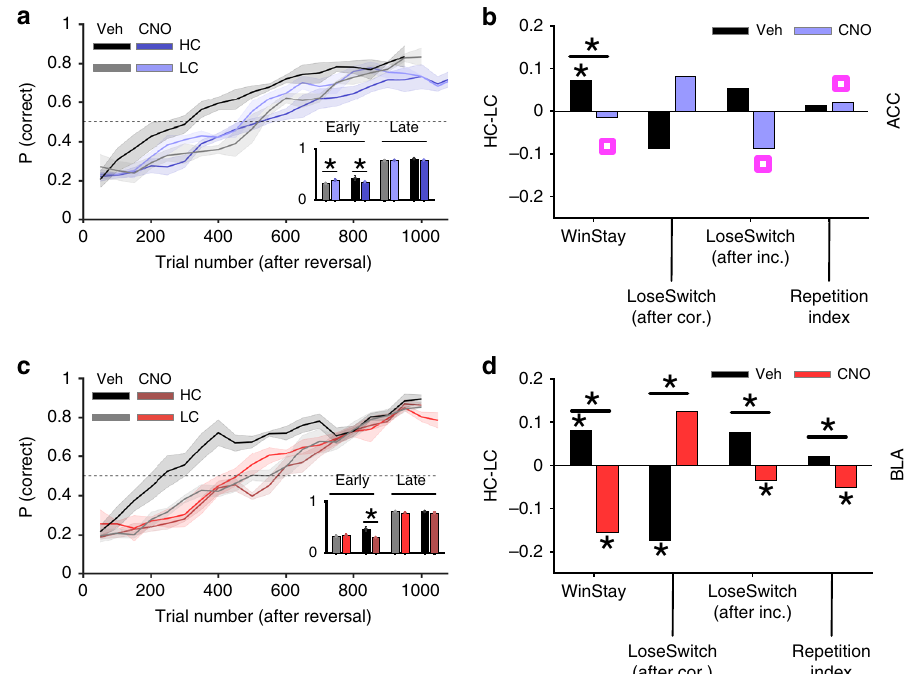
Fig. 7 ACC and BLA inhibition differentially modulate the effects of perceptual uncertainty on learning strategies and perseveration. a Learning curves (probability of correct response) after a reversal for rats prepared with ACC DREADDs following CNO (blue) or vehicle (Veh; black) administration. Plot shows the performance across all rats averaged over a sliding window of 100 trials for high-con fi dence (HC) and low-con fi dence (LC) conditions. The inset shows the average performance in early ( fi rst half of the trials) and late (last quarter of the trials) trials, demonstrating that either perceptual uncertainty or ACC inhibition decrease the rate of learning. Following ACC inhibition, rats eventually reach a similar performance level compared to the control condition (vehicle administration). (*) indicates a signi fi cant difference in median between the two conditions (chi-square test of ratio, p < 0.05). Error bars show